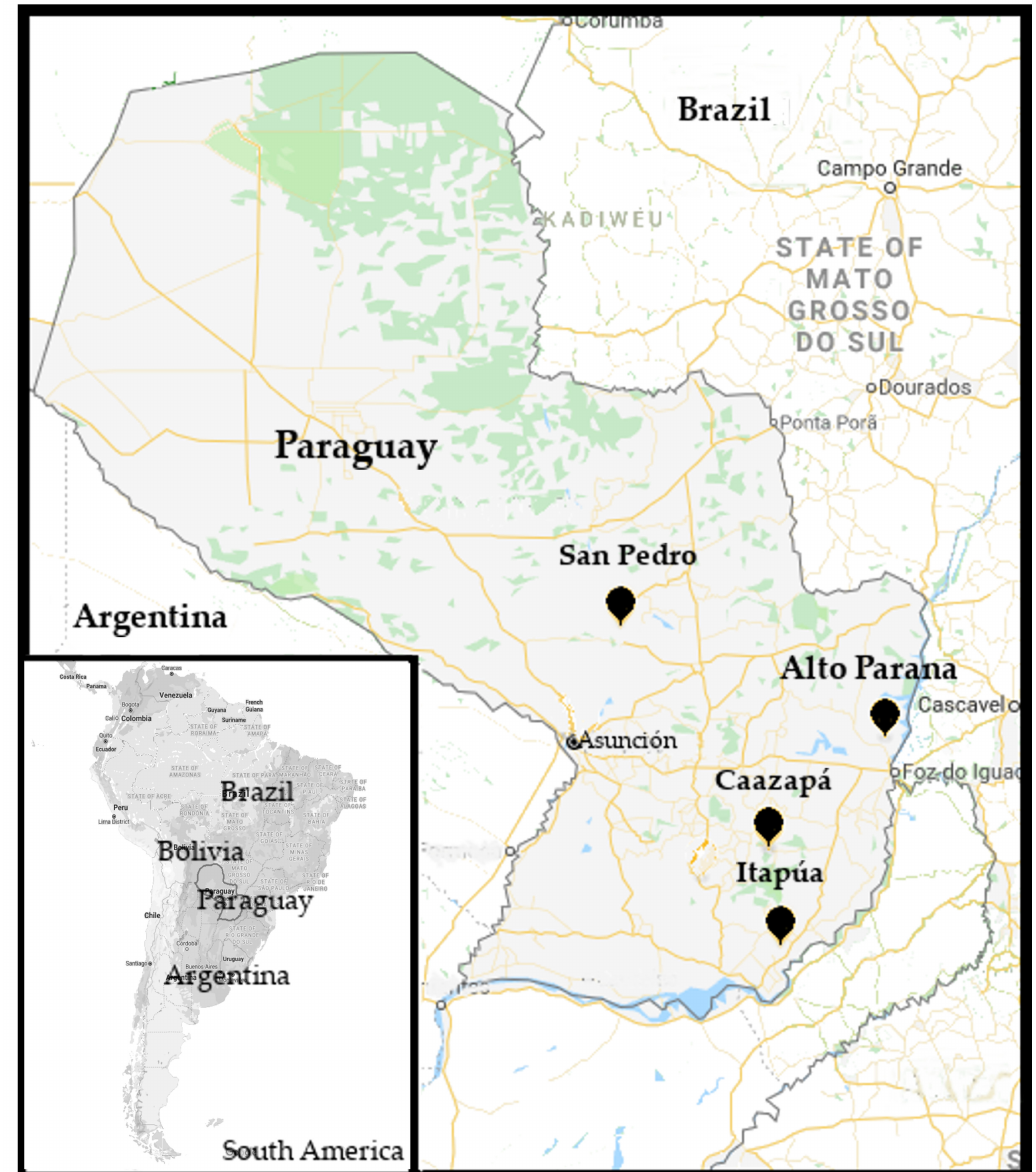
Figure 1. Map of Paraguay showing the geographical locations of San Pedro, Alto Parana, Caazapa and Itapua from which eucalypts samples were collected. Map obtained from Google maps (Google, Mountain View, CA,